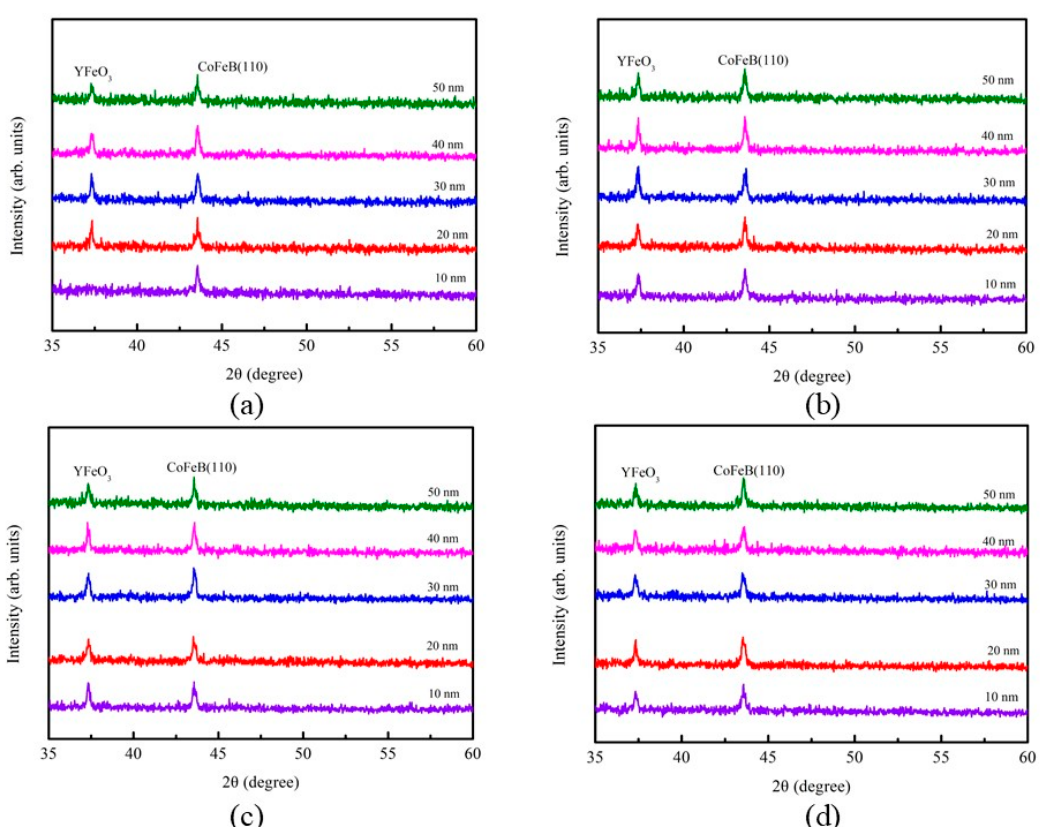
Figure 1. XRD patterns of CoFeBY films. ( a ) RT, ( b ) after annealing at 100 °C, ( c ) after annealing at 200 °C, ( d ) after annealing at 300 °C.